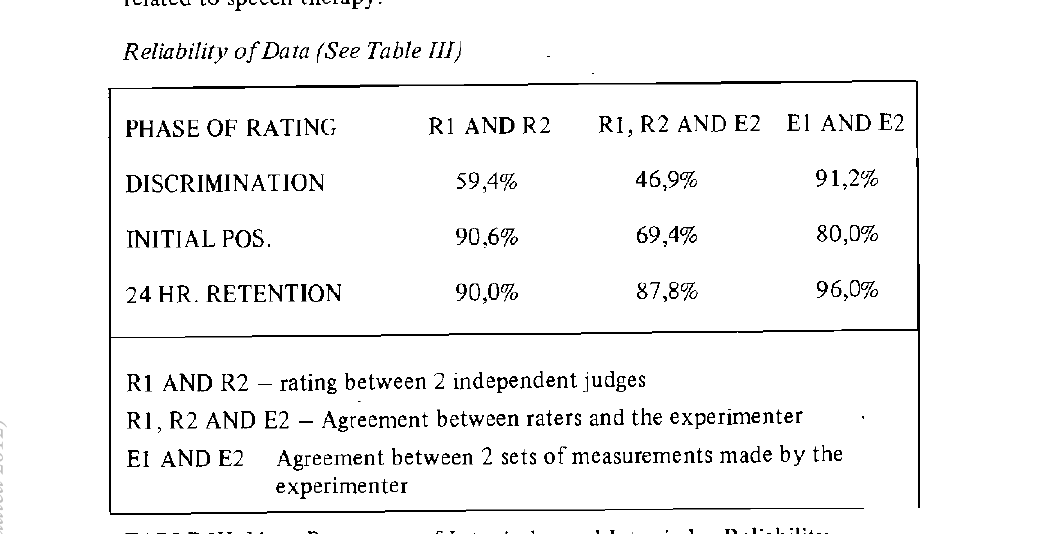
TABLE III. Mean Percentage of Inter-judge and Intra-judge